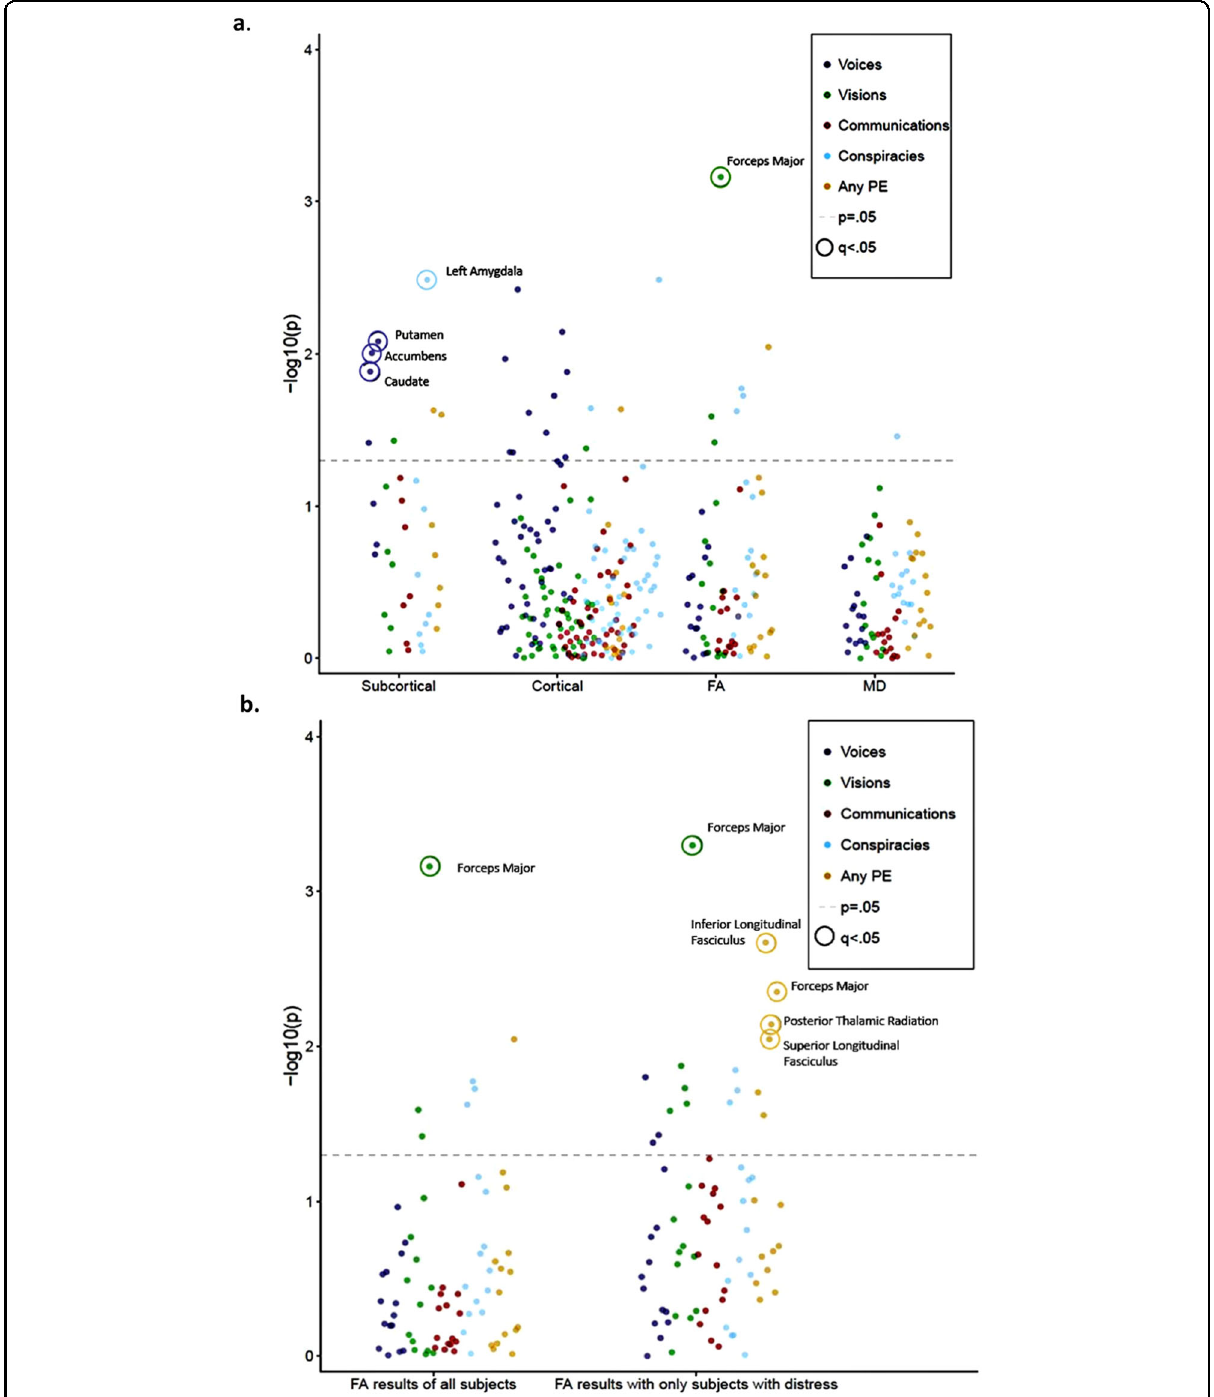
Fig. 1 Summary of results. a Summary of results of signi fi cant differences between groups with and without PLE of different types for each imaging type. Each colored dot represents the adjusted p -value of different types of PLEs. Encircled dots (q) illustrate signi fi cant fi ndings (with p corrected < 0.05). b Signi fi cant associations of FA differences in all subjects and those reporting distress during PLEs. Each colored dot represents the adjusted p -value of different types of PLEs. Encircled dots (q) illustrate signi fi cant fi ndings (with p corrected <